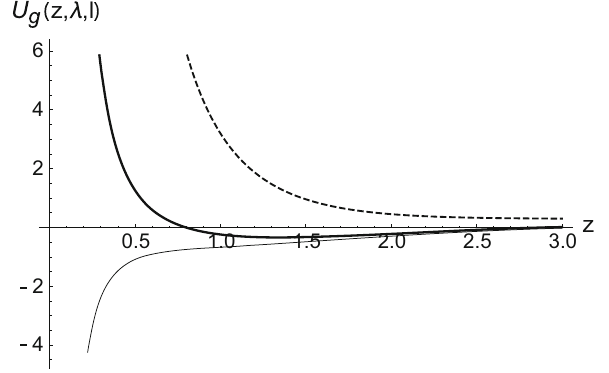
Fig. 12 Gravitational (and scalar field) Schrödinger potential in the exotic string model for λ = 0 . 1 ) and c = 0 . 6. Thin line ( l = 0 ) , thick line ( l = 1 ) and dashed line l =